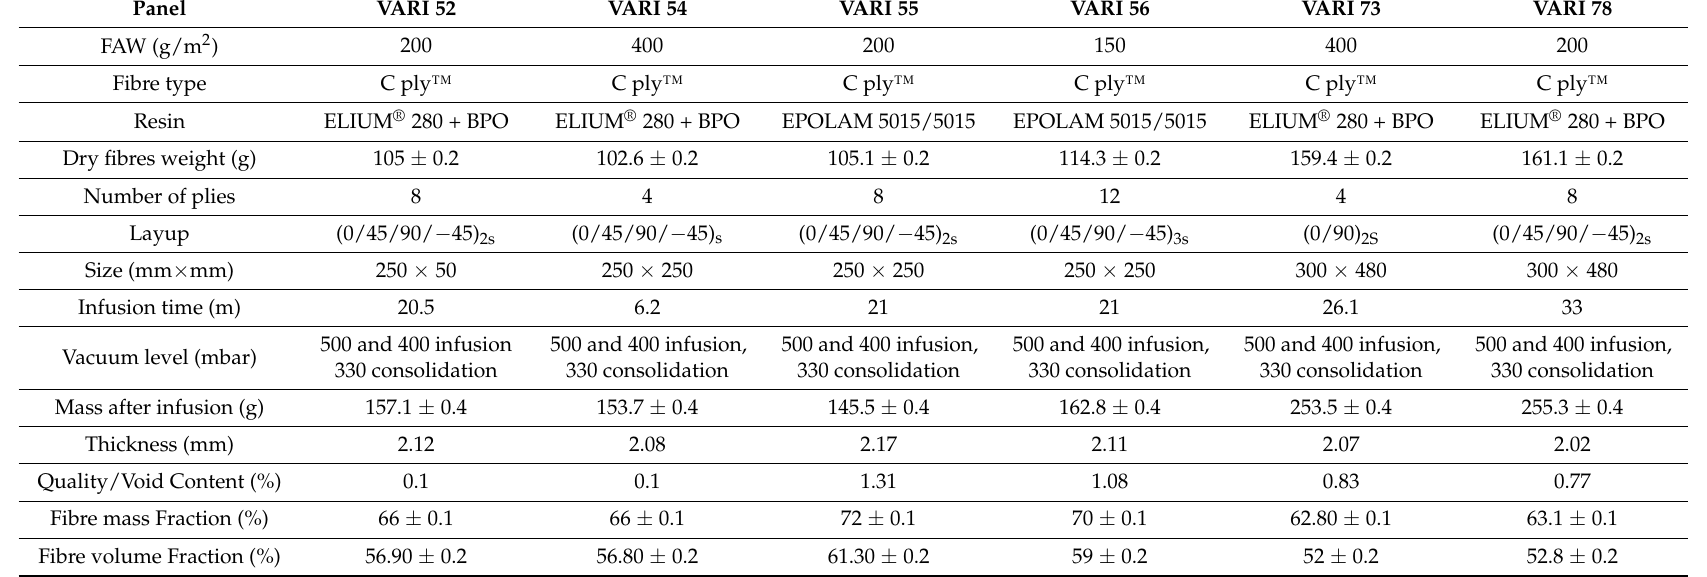
Table 6. Summary of various panels injected with optimised process